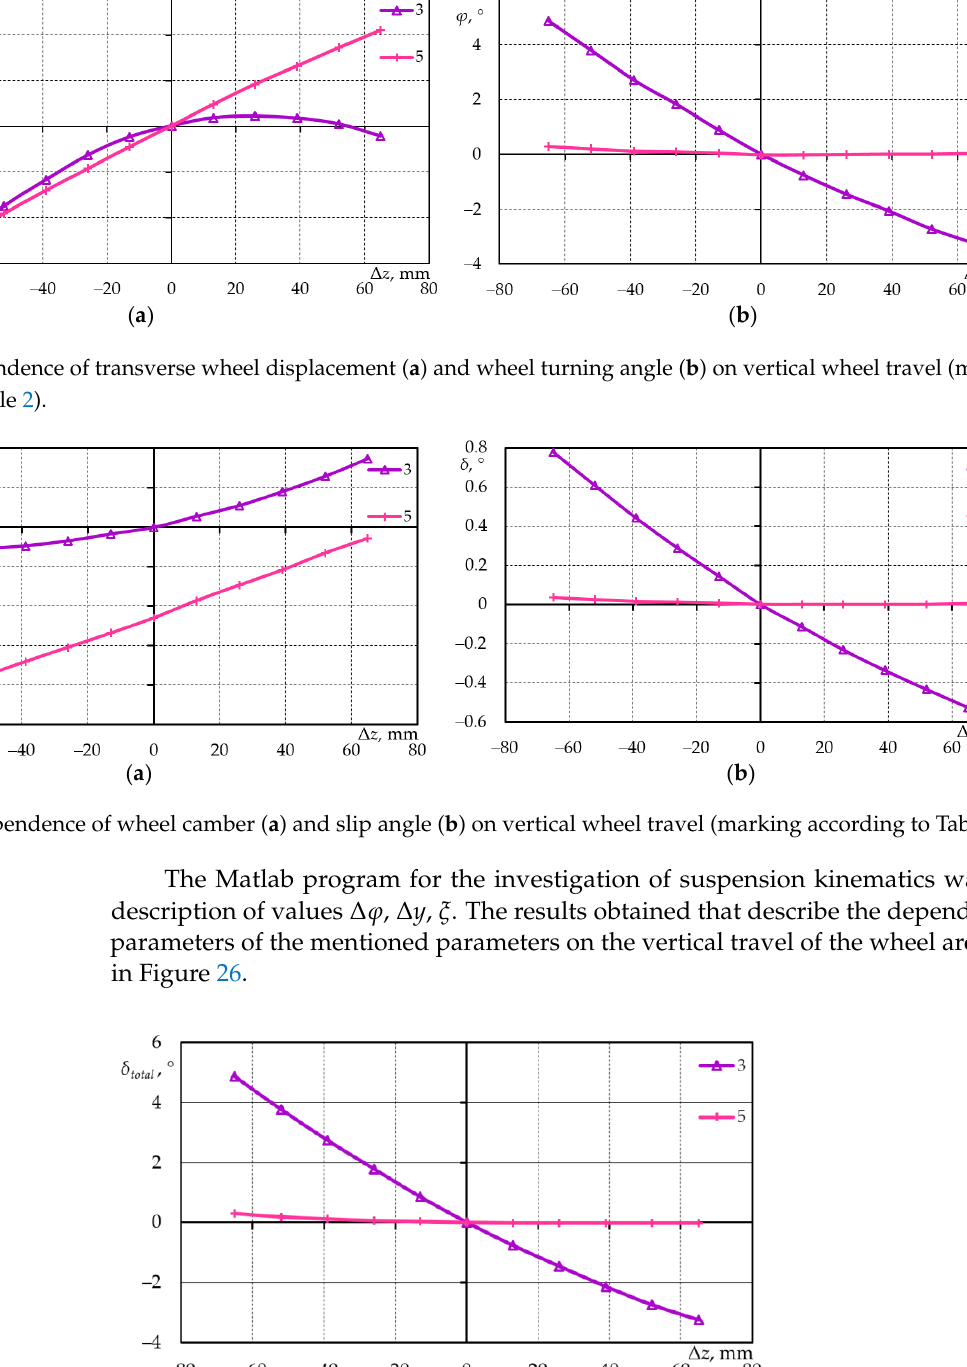
Figure 26. Dependence of total slip angle on vertical wheel travel (marking according to Table 2).